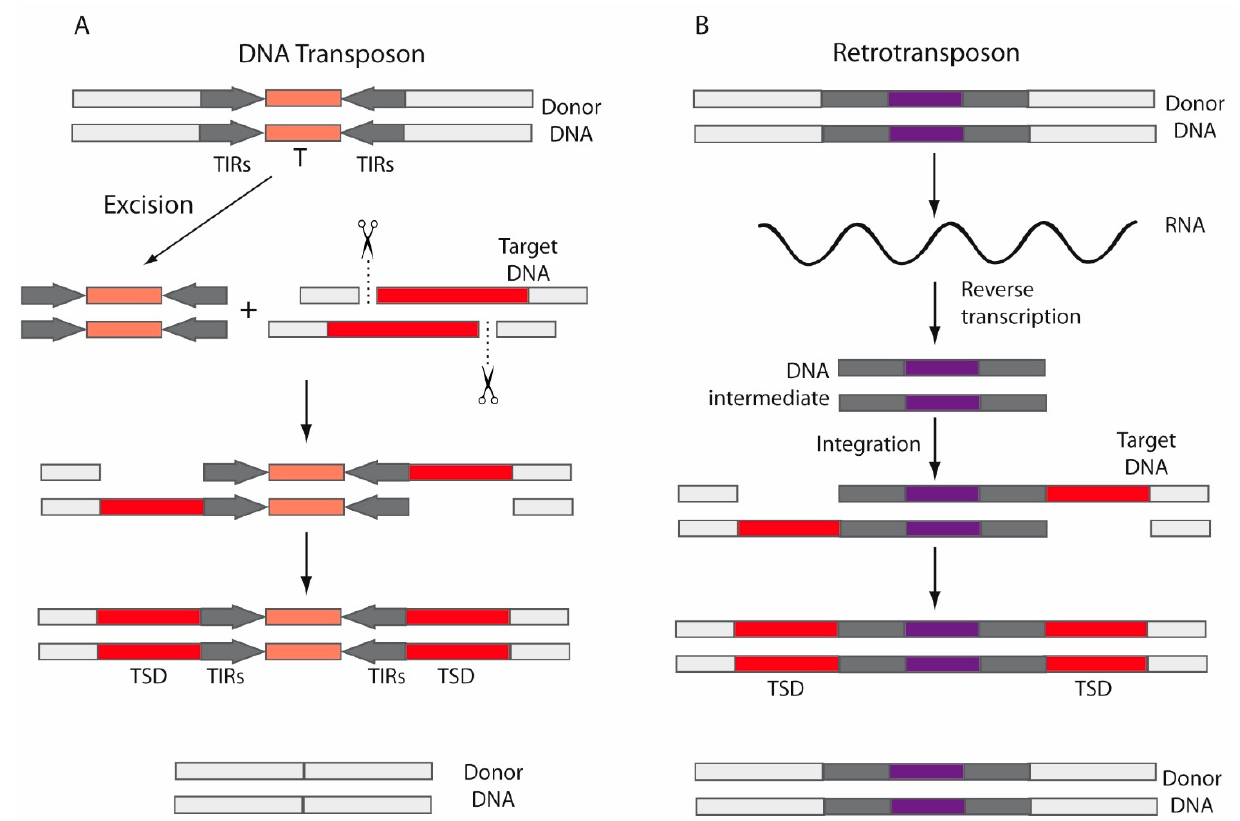
Figure 2. Mechanisms for mobilization. ( A ) DNA transposons move via a “cut and paste” mechanism, by which a transposase (T) mediates double-strand DNA cleavage and insertion. The DNA sequence is excised by the transposase from one region (donor DNA) and integrated into another region of the genome (target DNA). Transposases are flanked by terminal inverted repeats (TIRs). ( B ) Retrotransposons move via a “copy and paste” mechanism, using RT to transcribe the RNA back into DNA and integrases or endonucleases to insert it into a new location. After insertions, the DNA at the target site duplicates, producing target site duplications (TSDs).